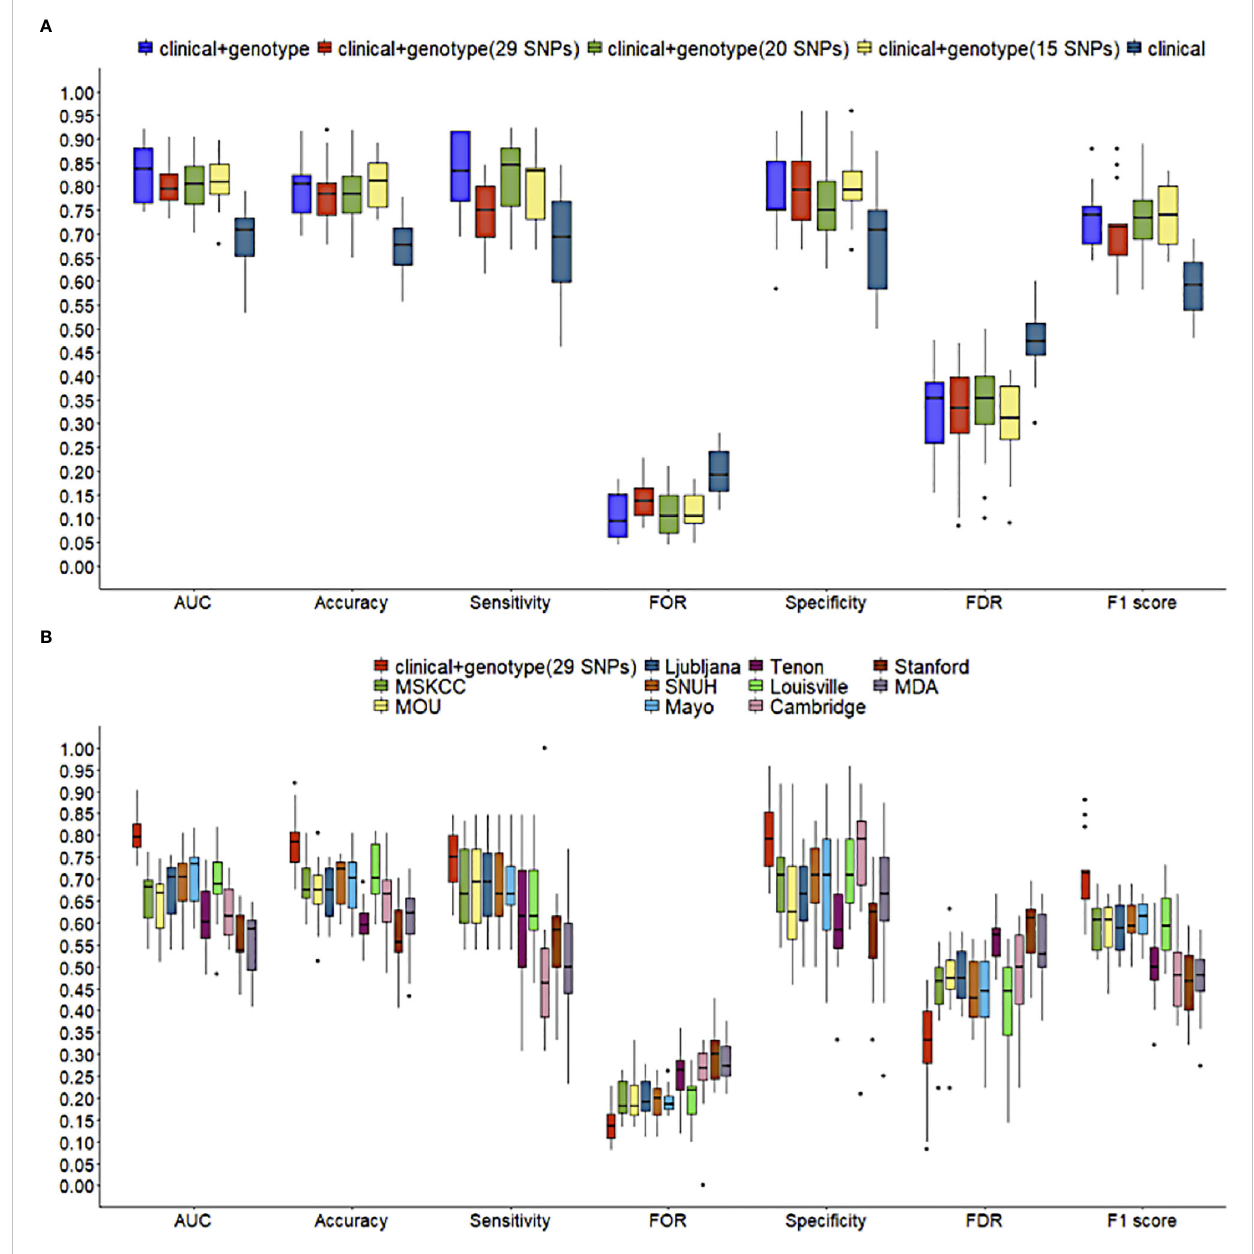
FIGURE 5 Comparisons of predictive performance in 5-fold cross validation. (A) among NSLN metastasis predictive models using different numbers of SNPs, and (B) between the clinical and 29 signi fi cant SNPs combining model in this study and ten published NSLN metastasis predictive models. The line in box represents the